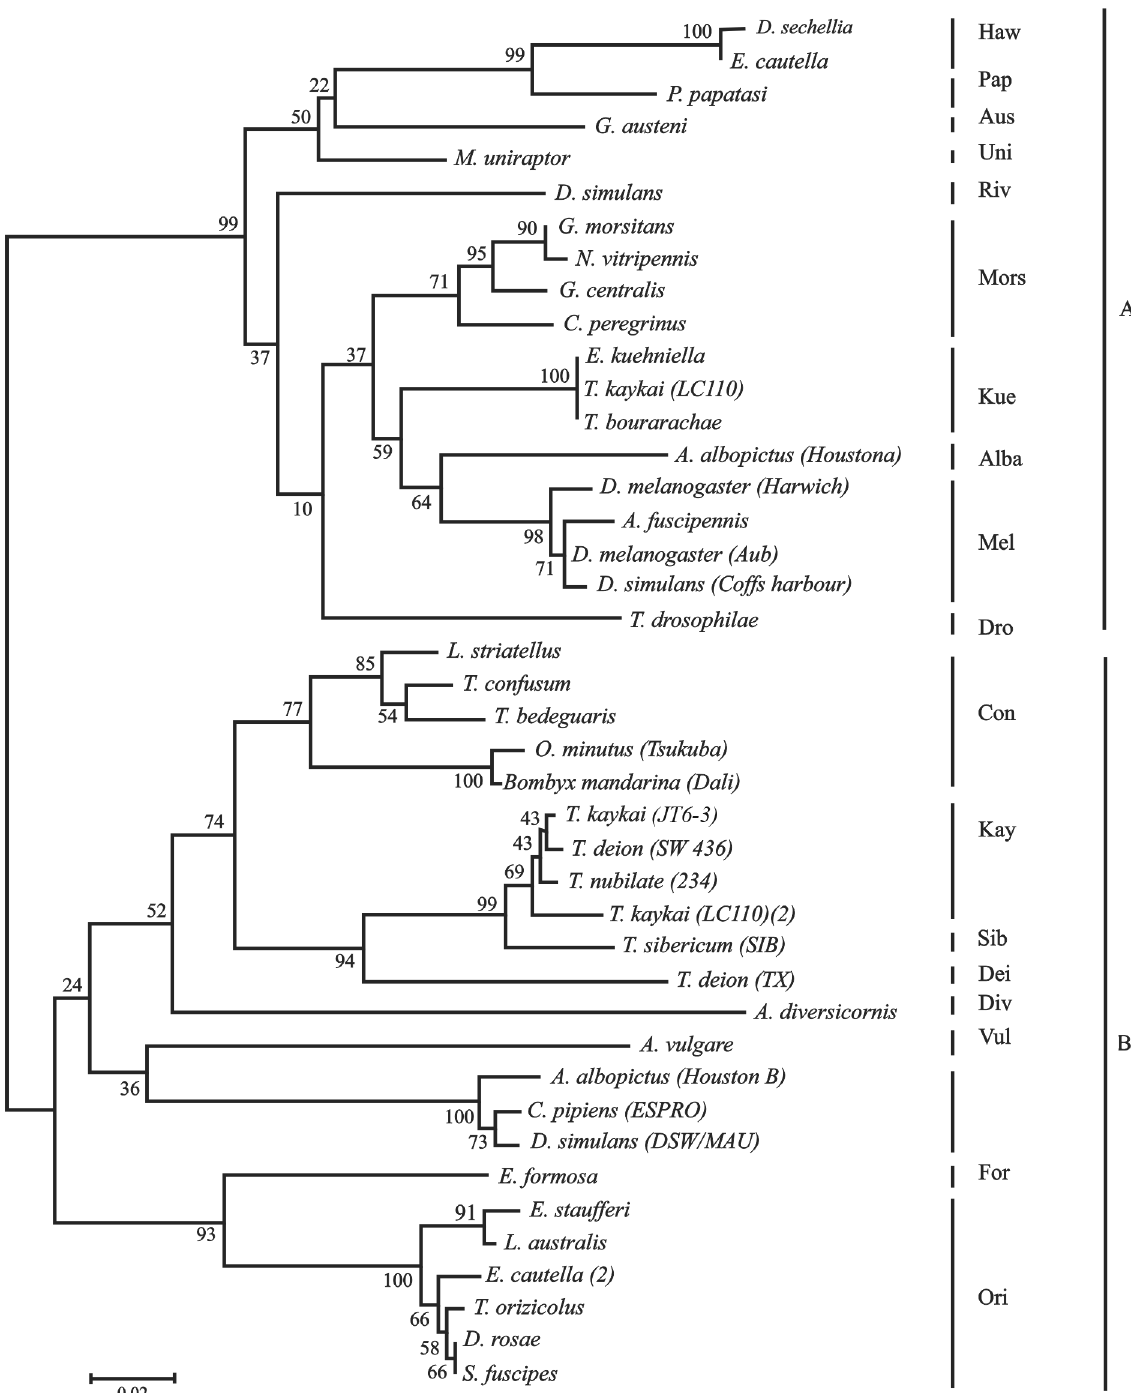
Figure 2 - Phylogenetic tree of Wolbachia based on wsp gene sequences. The name of the host arthropod species was followed by the group designation. The name `Bombyx mandarina(Dali)’ represents Wolbachia in wild silkworm from Dali in Yunnan. The tree was constructed by the Neighbour-Joining algorithm. Numbers on the nodes indicated percentages of 1,000 bootstrap